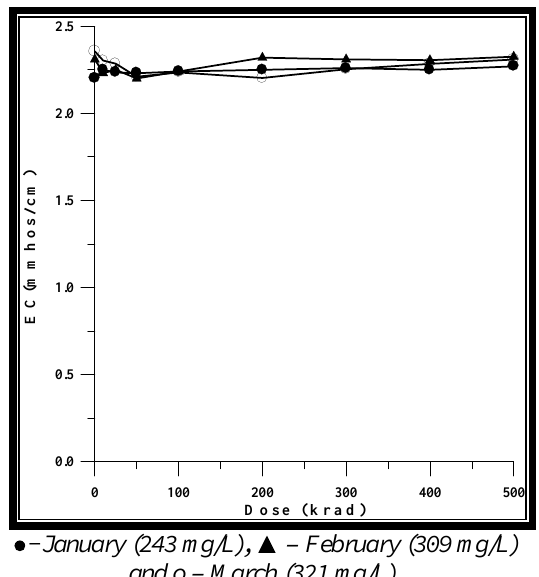
Figure 3: EC values of irradiated sample of wastewater for BOD 5